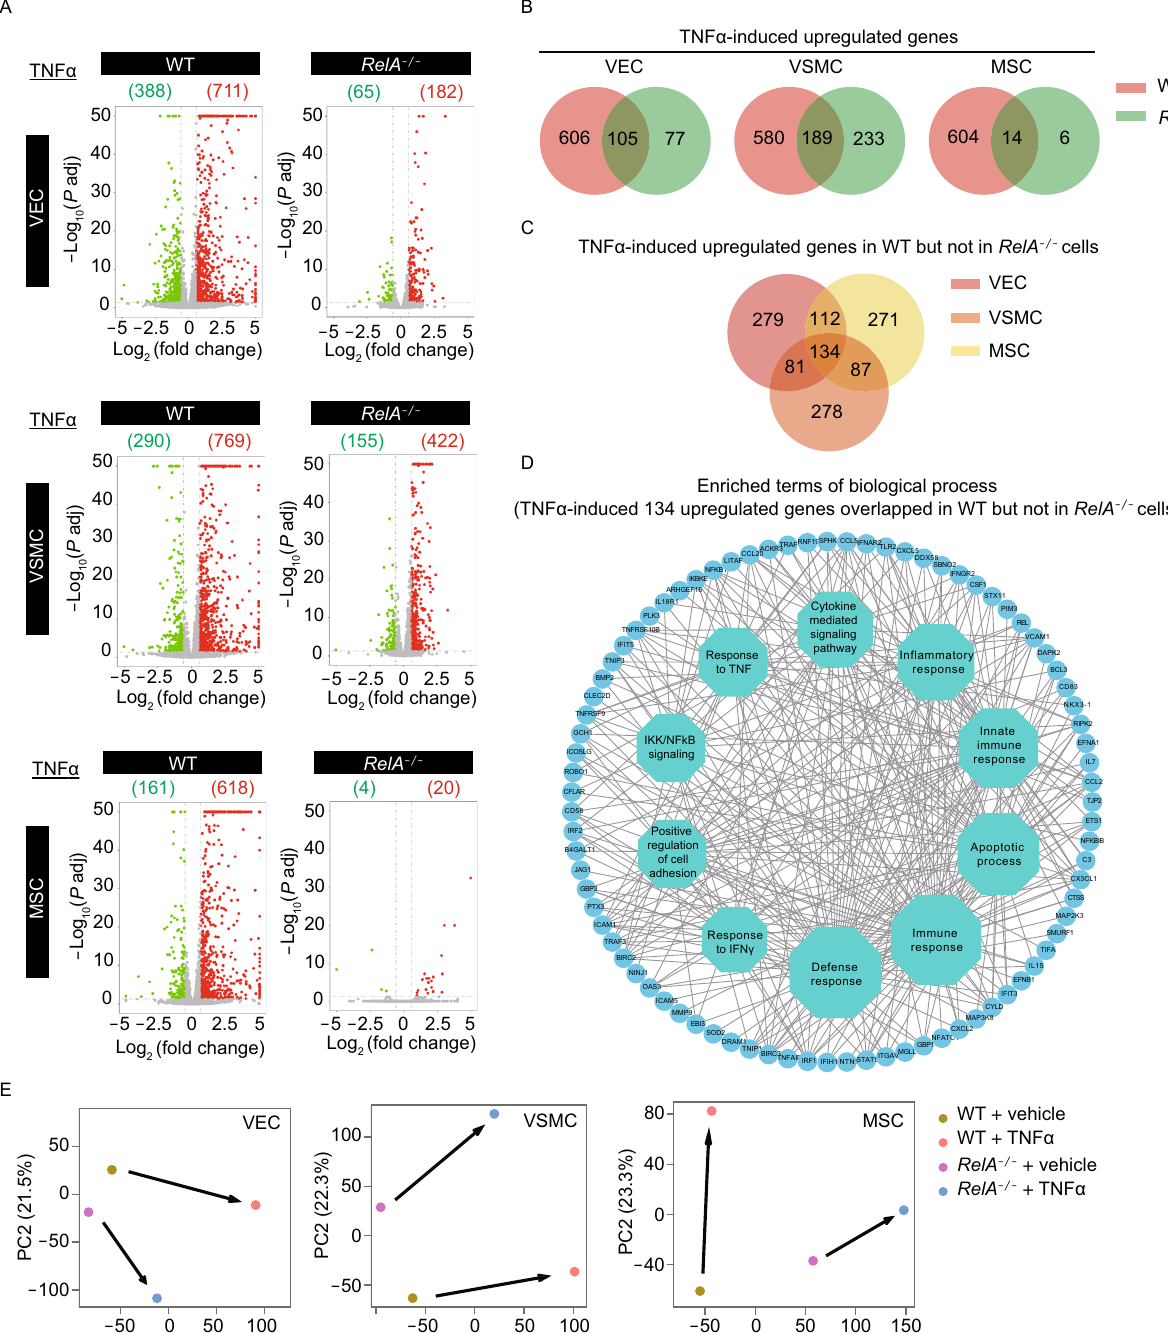
Figure 9. Transcriptomic analysis revealed RelA de fi ciency-induced vascular cell dysfunction upon TNF α treatment. (A) Volcano plots showing the differentially expressed genes between basal and TNF α -treated conditions in WT and RelA − / − VECs, VSMCs and MSCs. Green color indicates downregulated genes; red color indicates upregulated genes. The number listed in red or green indicates the number of differentially expressed genes. (B) Venn diagrams showing the overlap of upregulated genes in WTand RelA − / − VECs, VSMCs and MSCs upon TNF α induction. (C) Venn diagram showing the overlap of upregulated genes in WT but not in RelA − / − VECs, VSMCs, and MSCs upon TNF α induction. (D) Network diagram showing enriched GO biological process terms of upregulated genes in WT but not in RelA − / − VECs, VSMCs and MSCs upon TNF α treatment. The size of octagons represents the number of upregulated genes enriched in each term of biological processes. (E) Principal component analysis (PCA) showing a transcriptional pattern shift upon TNF α induction in WT and RelA − / − VECs, VSMCs and